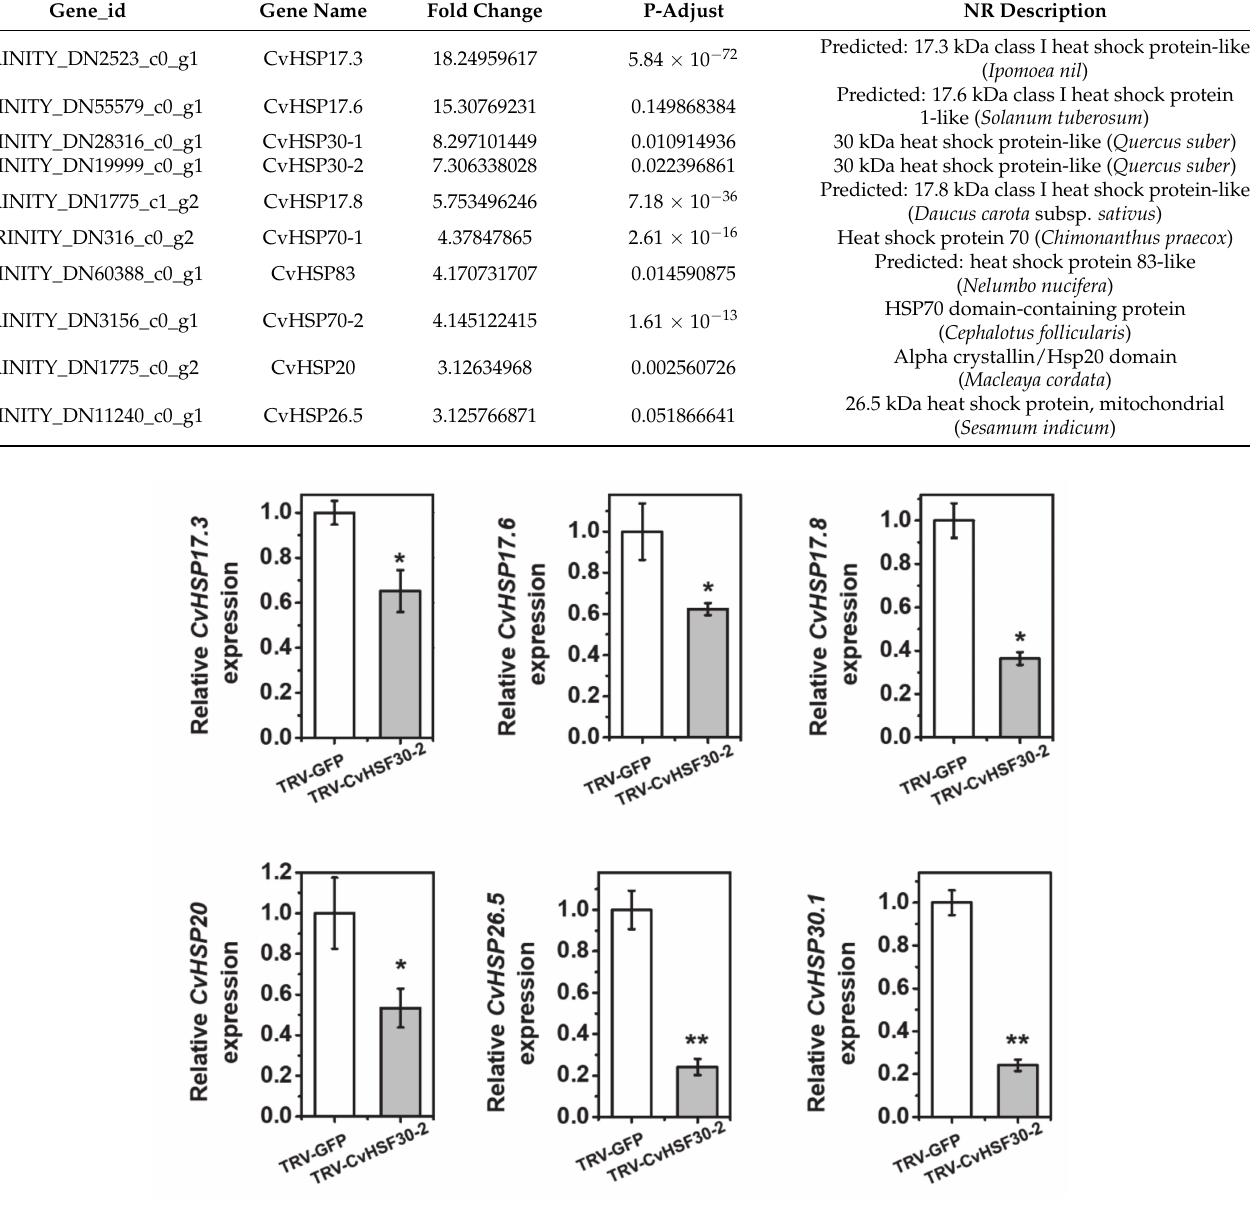
Figure 6. Expressions of CvHSP17.3 , CvHSP17.6 , CvHSP17.8 , CvHSP20 , CvHSP26.5 and CvHSP30.1 in CvHSF30-2 -silenced plants by VIGS. Error bars represent the standard error of three biological replicates. Asterisks indicate a significant difference between TRV-GFP and TRV-CvHSF30-2 by t-test. * p < 0.05; ** p <